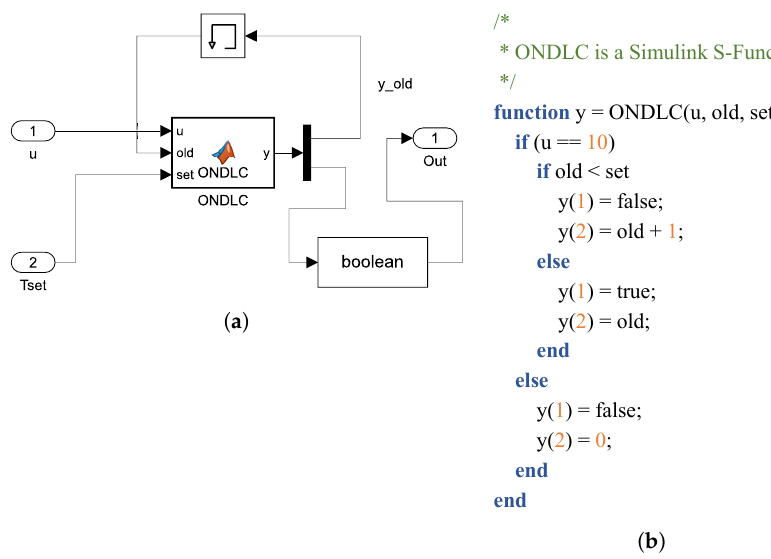
Figure 1. Model example with signal unput. ( a ) model; ( b ) code of ONDLC in